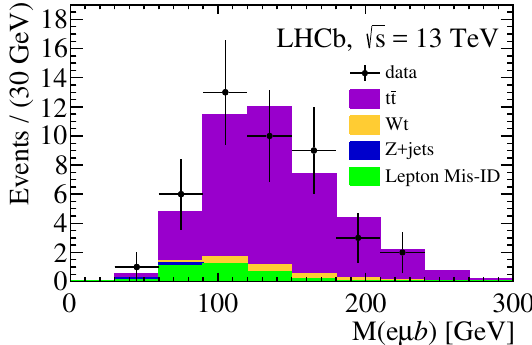
Figure 4 . The combined invariant mass of the muon, electron and b -jet in data compared to the expected contributions. The tt signal yield is determined to be the number of selected events minus the sum of the expected backgrounds. The multiboson background is determined to be